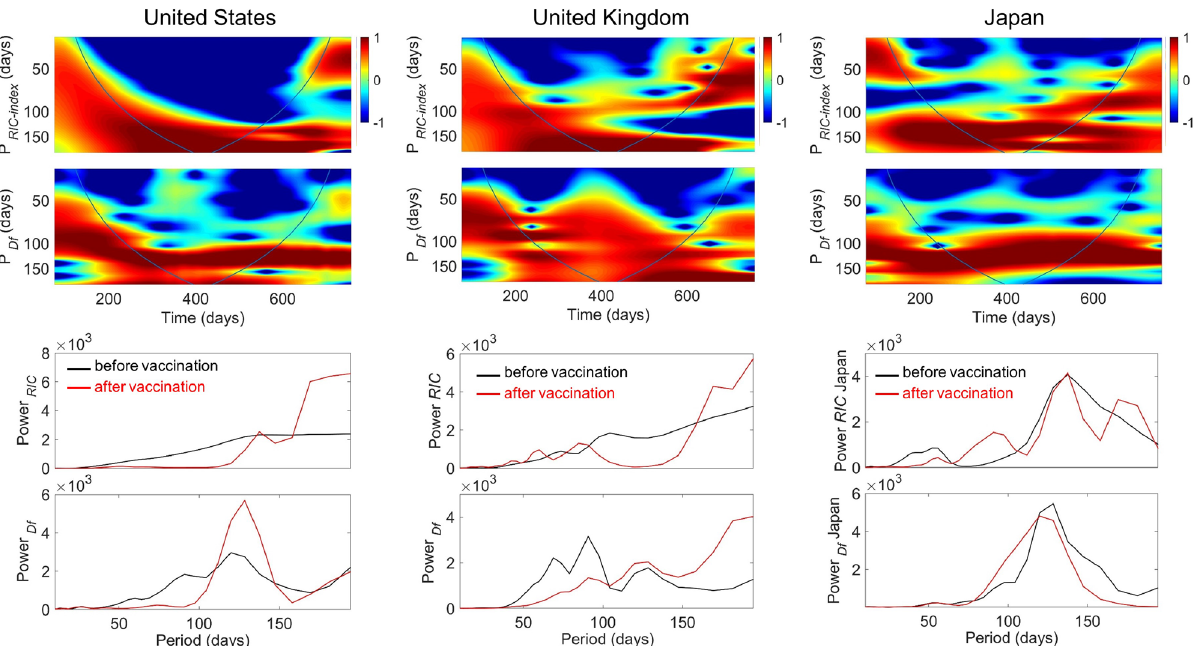
Figure 4. Wavelet and Fourier Transform of epidemic spreading in United States, United Kingdom and Japan from 15/03/2020 to 28/01/2022. The Covid-19 spreading is visualized vs. time by wavelet transform giving the Local Wavelet Power Spectrum (LWPS) of the RIC index and the daily deaths per million population (Df) time series in the upper panels. The wavelet analysis decomposes the spreading waves hidden in time series data at different scales. Power is color-coded from − 1 (blue) to 1 (red). In the lower panels we show the Global wavelet power spectrum (GWPS) of the period of epidemic periodic travelling waves for infections measured by the RIC index and the new deaths, before the vaccination campaign for t < t v (black lines) and after the onset of the vaccination campaign for t > t v (red